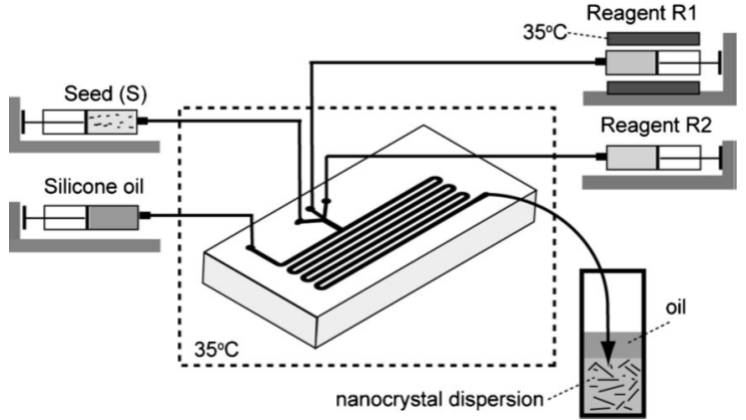
Figure 21. Droplet-based synthesis of gold nanorods [31].